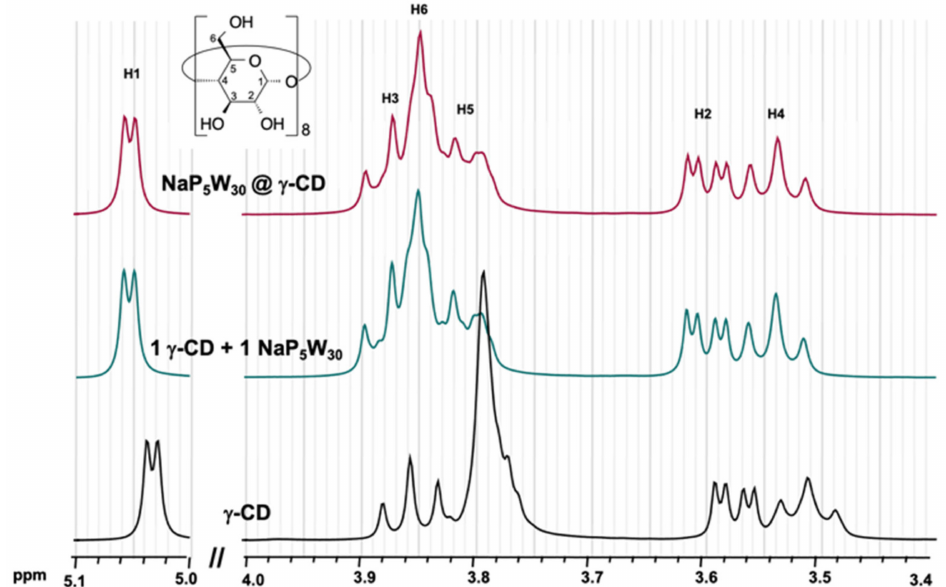
Figure 3. 1 H NMR spectra of aqueous solution 10 mM γ -CD, an equimolar solution (10 mM) of a mixture of K 14 [NaP 5 W 30 O 110 ] and γ -CD, and 10 mM aqueous solution of NaP 5 W 30 • 1CD